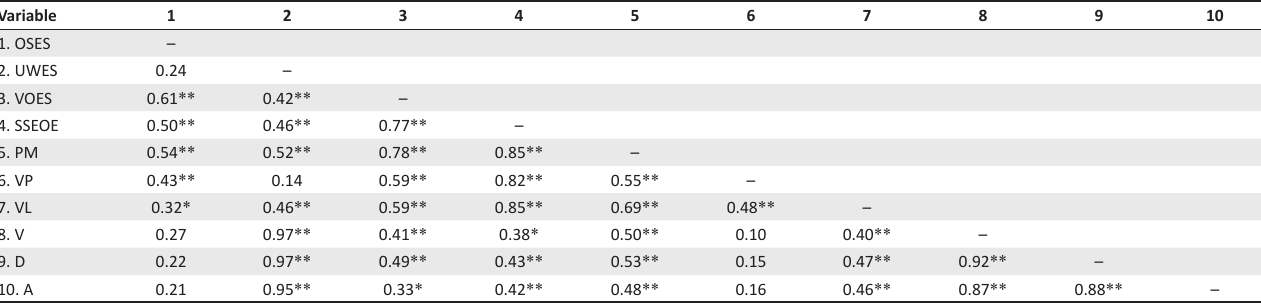
TABLE 2: Correlations of the full scales and subscales of measures.